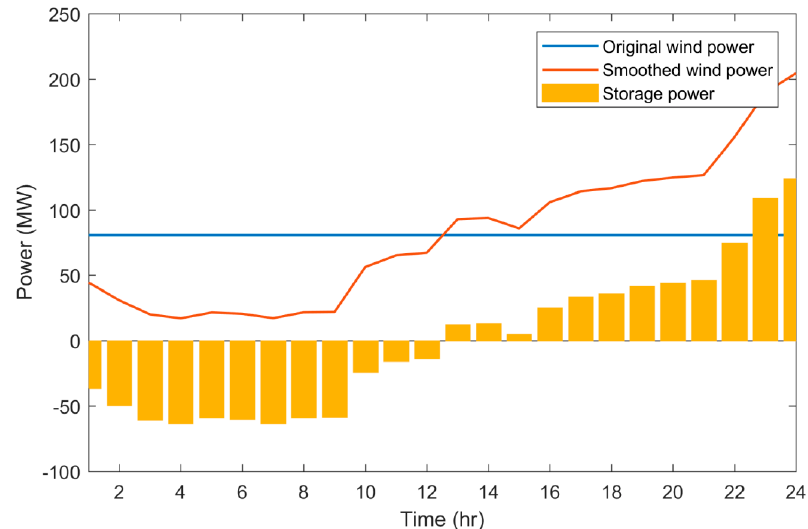
Figure 9. Advantage of storage in smoothing wind energy fluctuation.